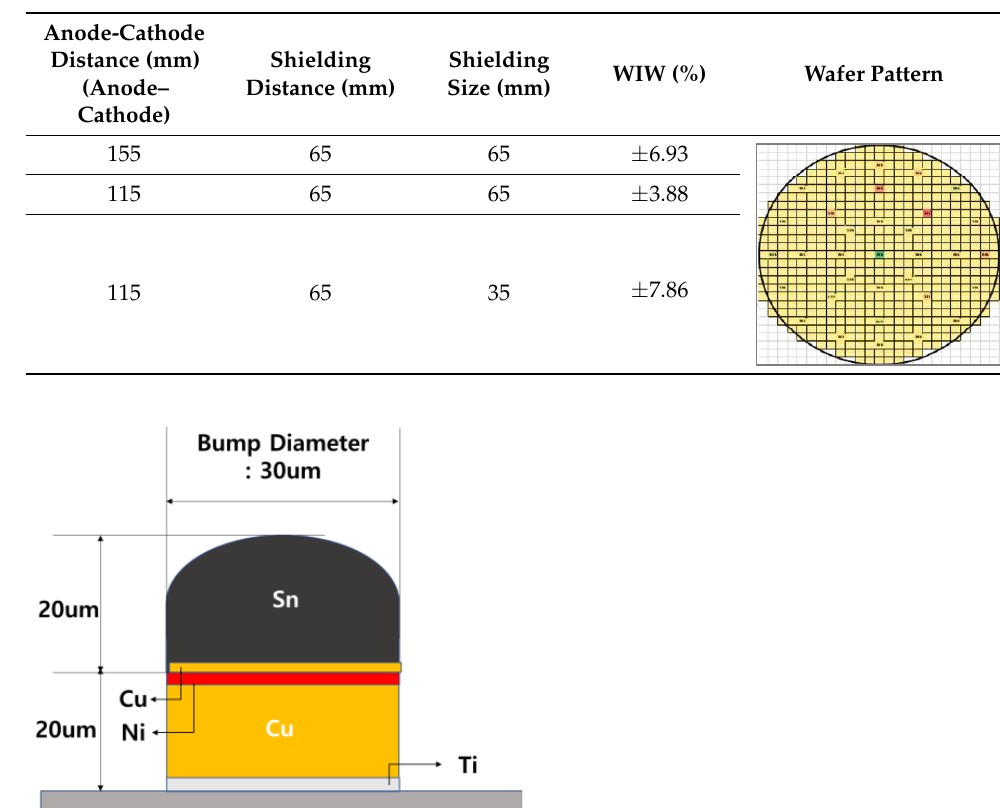
Figure 7. Pure Sn bump formation design with a diameter of 30 µm. (b) Results of pure Sn bump geometry formed by plating